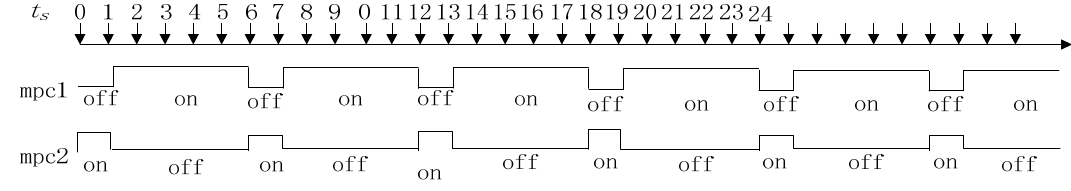
Figure 8. Collaboration diagram for MPC 1 and MPC